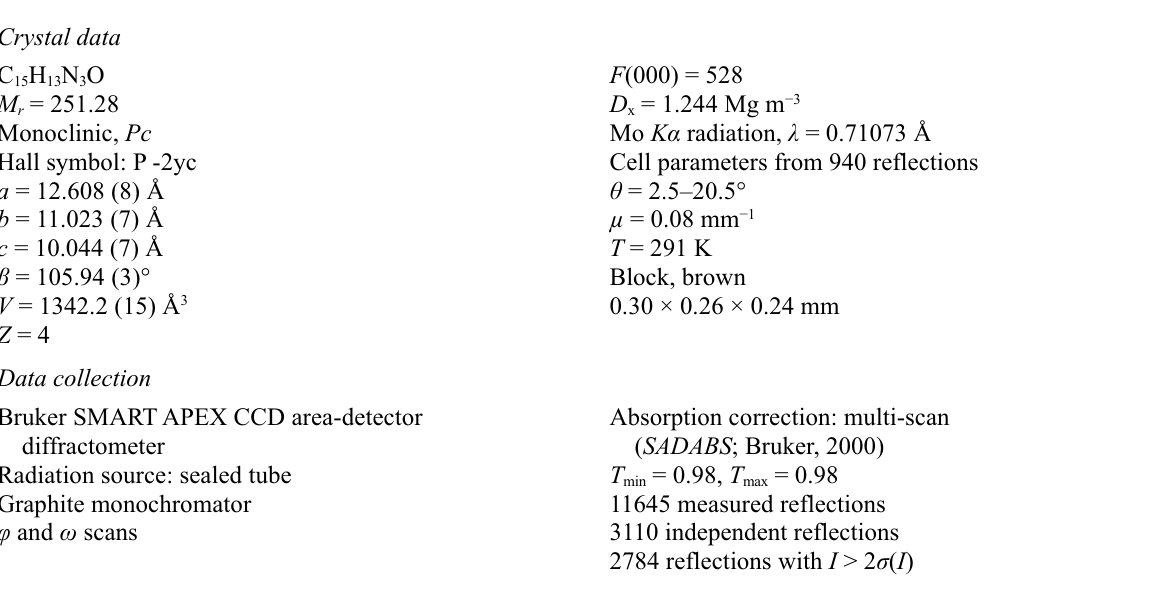
ORTEP plot of (I) showing the atom numbering scheme. Displacement ellipsoids are drawn at the 30% probability level. N ′